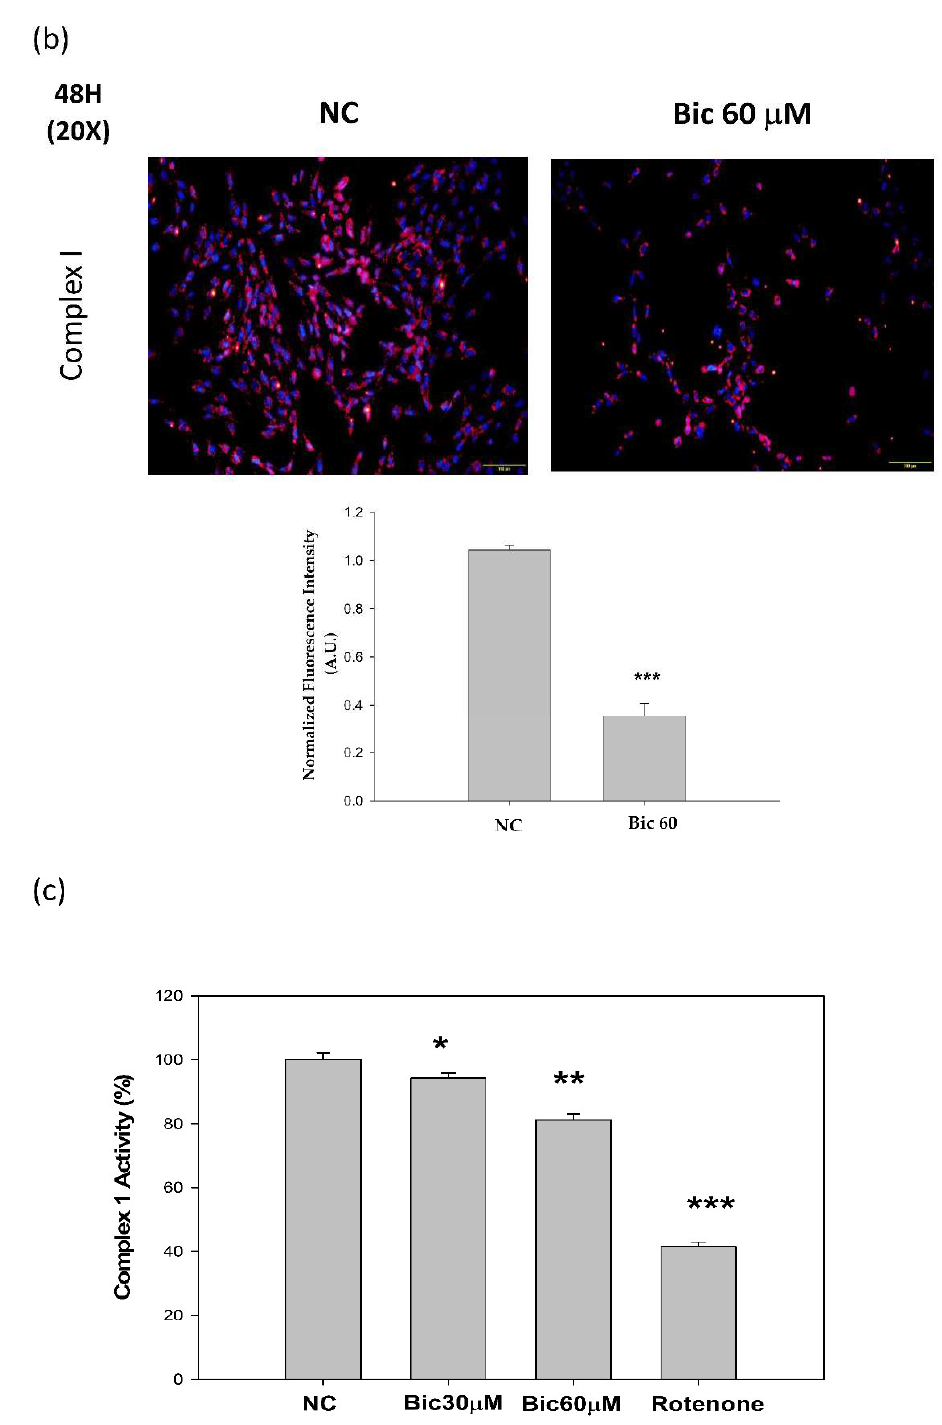
Figure 4. Bicalutamide induces mitochondria respiratory complex I deficiency. Representative western blot and densitometric analysis showing level of NDUFB8 proteins in RMC cells following 0~60 µ M of bicalutamide treatment for 24 and 48 h ( β -Actin is shown as normalization control). Bar graph represents the mean ± SD of three independent experiments: §§§ p < 0.001 compared to Bic 0 µ M at 48 h. ¶¶¶ p < 0.001 compared to Bic 30 µ M at 48 h ( a ). RMC cells were treated with 0~60 µ M of bicalutamide for 48 h and subjected to immunofluorescence stain ( b ) and activity assay of complex I at 48 h ( c ). Here, 0.25 µ M of rotenone is shown as positive control for complex I inhibition. Bar graph represents the mean ± SD of three independent experiments. * p < 0.05, ** p < 0.01, *** p < 0.001 compared to normal control